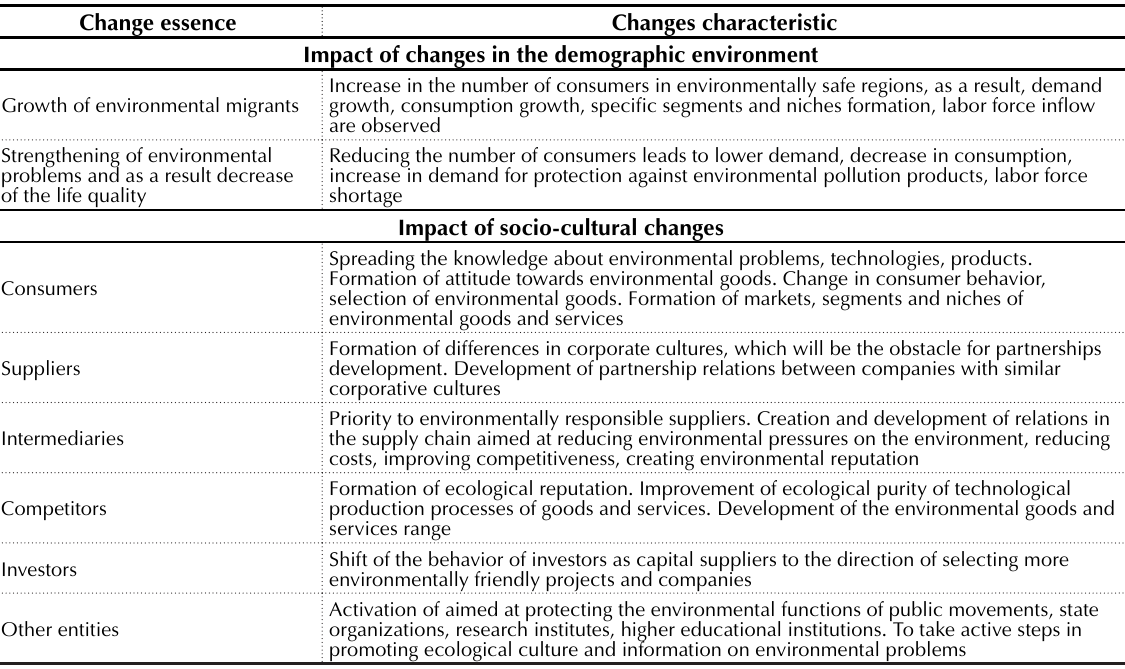
Table 2. Changes in the market player micro-environment under the influence of environmental